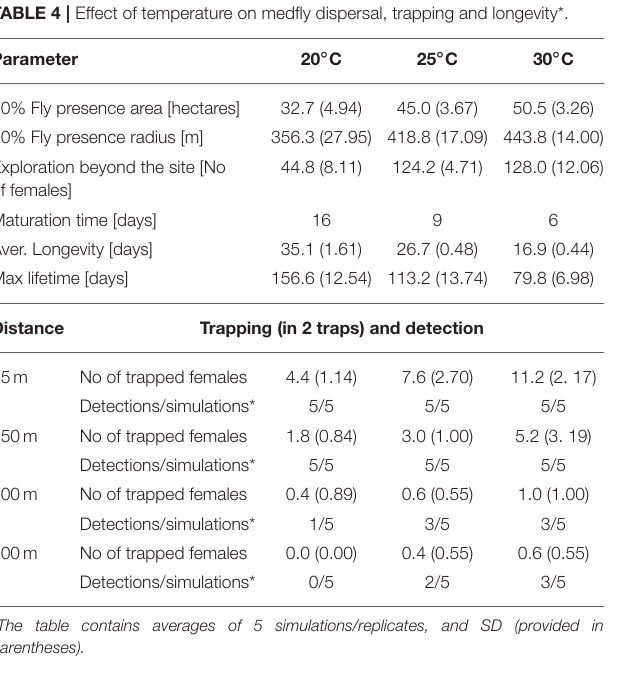
TABLE 4 | Effect of temperature on medfly dispersal, trapping and longevity*.